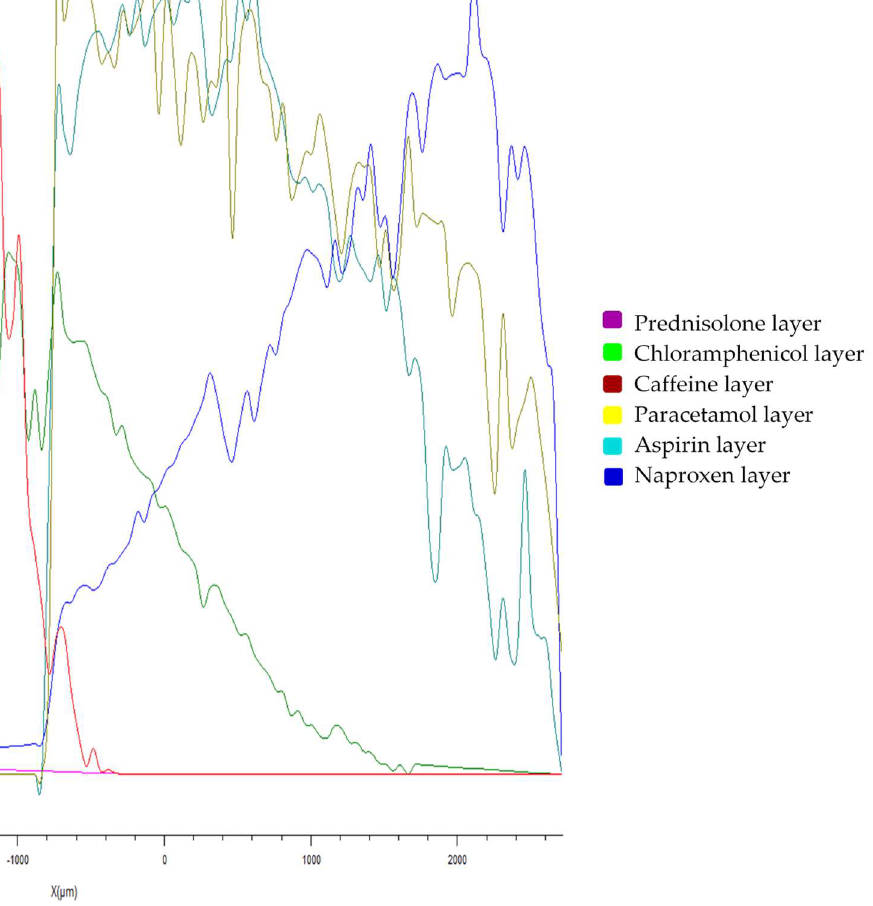
Figure 5. Drug distribution profiles in the Y -dimension of the polypill showing the diffusion between layers in the paracetamol, aspirin, and naproxen layers, with a tight distribution in the caffeine and prednisolone layers.